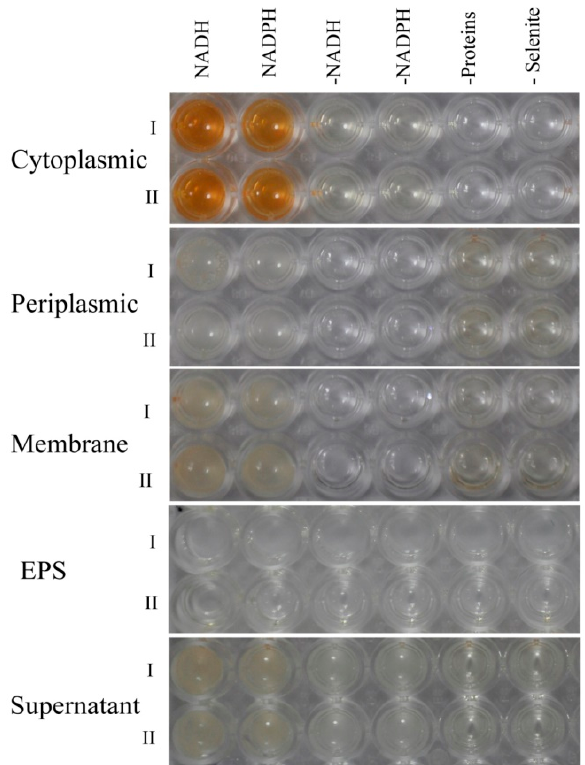
Figure 8. Enzymatic assay on different cell compartments (cytoplasmic, periplasmic, and membrane fractions) or culture broth fractions (supernatant, and exopolysaccharide) with selenite reduction activity. All assays were done in duplicate (indicated by roman numerals), with the addition of 5.0 mM SeO 32 − and 2.0 mM NADH or NADPH. Three negative controls were also used: Without protein fractions or culture broth fractions, without selenite, and without NADH or NADPH.